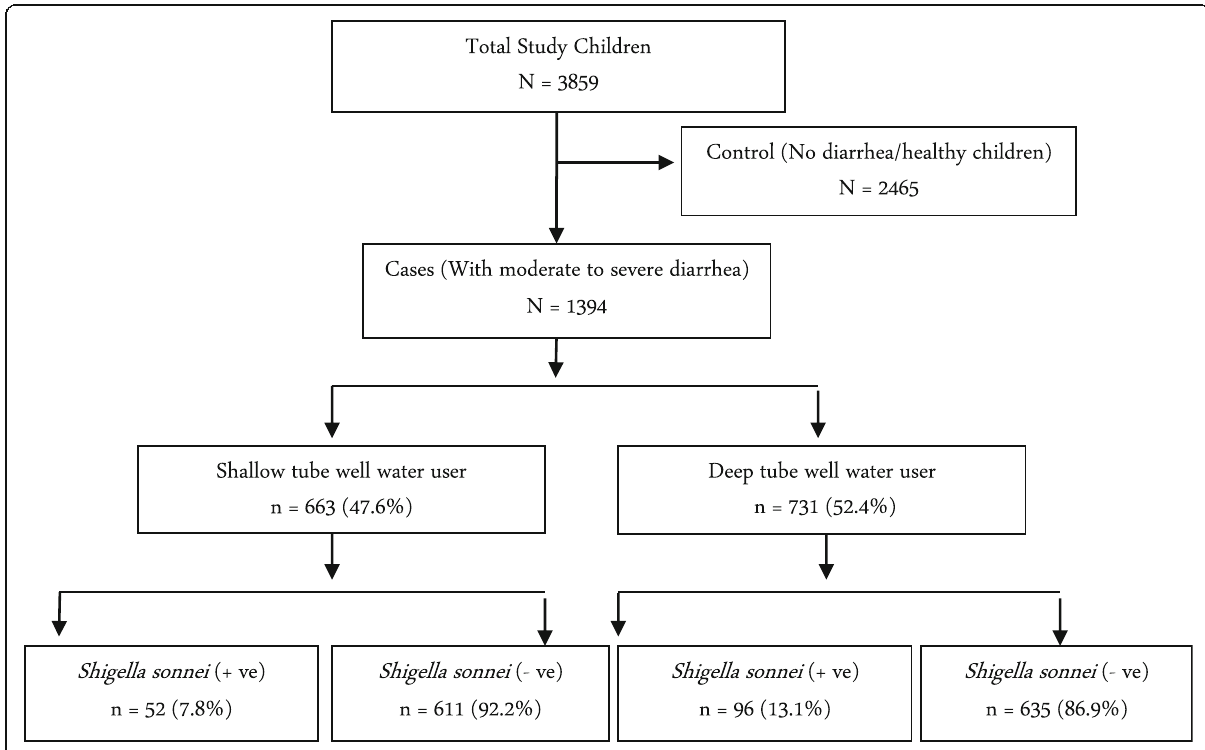
Fig. 1 Study profile of enrolled children (cases with moderate-to-severe diarrhea)